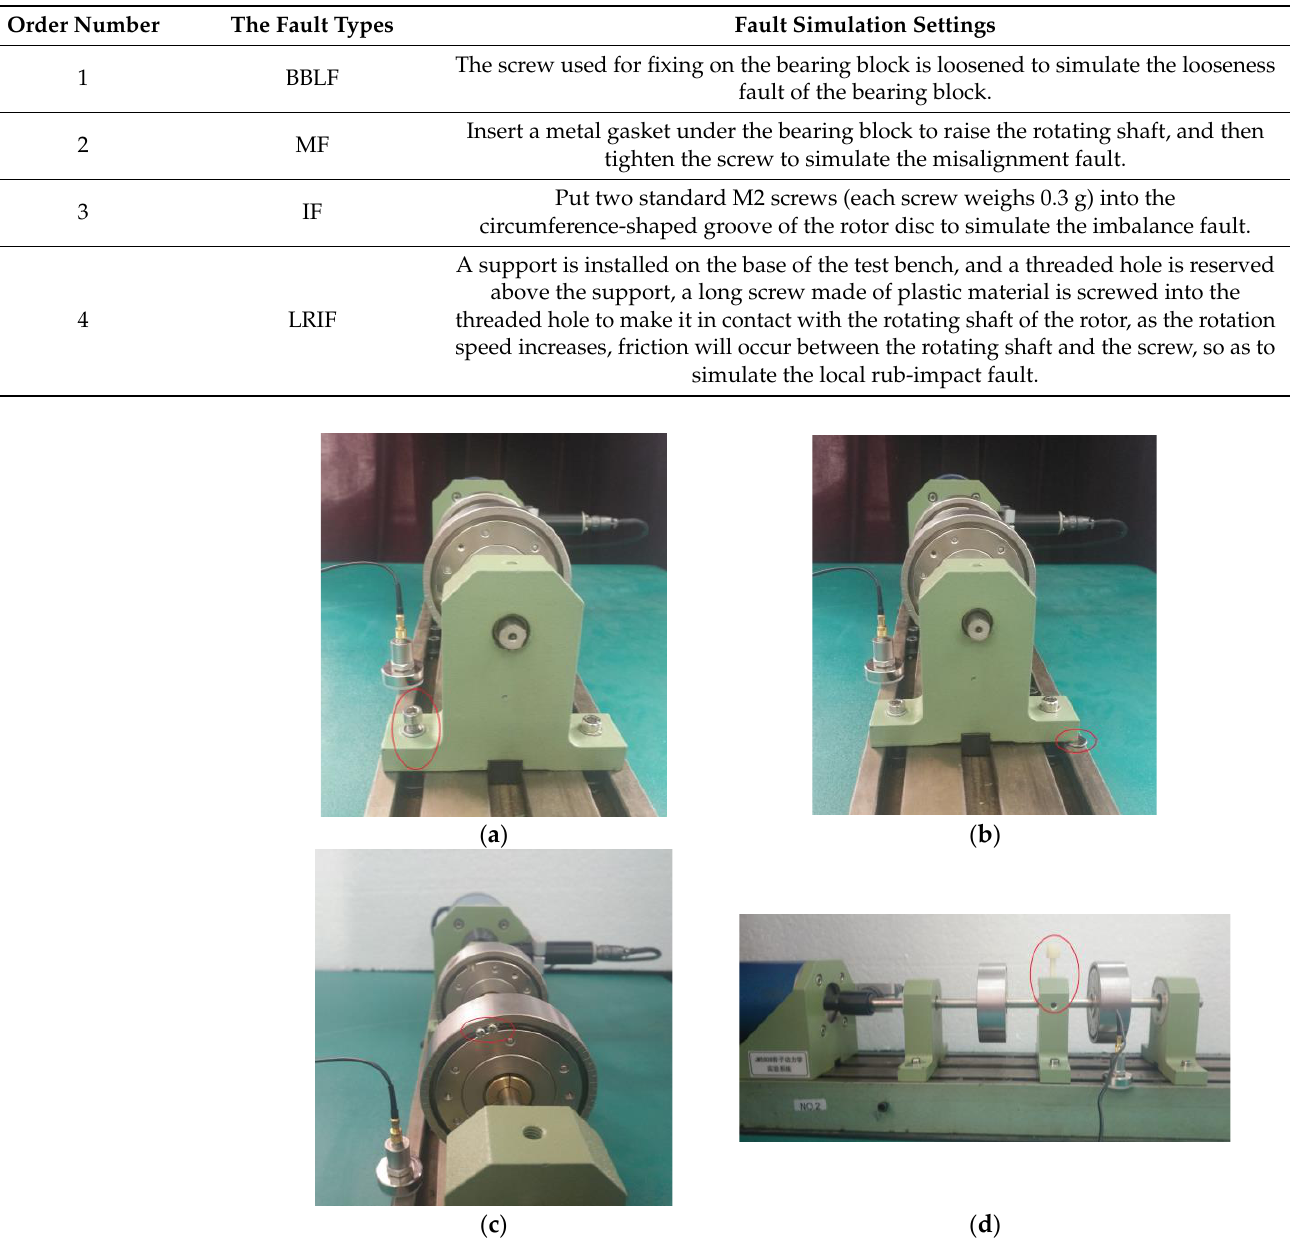
Figure 5. Four kinds of rotor faults: ( a ) BBLF, ( b ) MF, ( c ) IF, ( d ) LRIF.